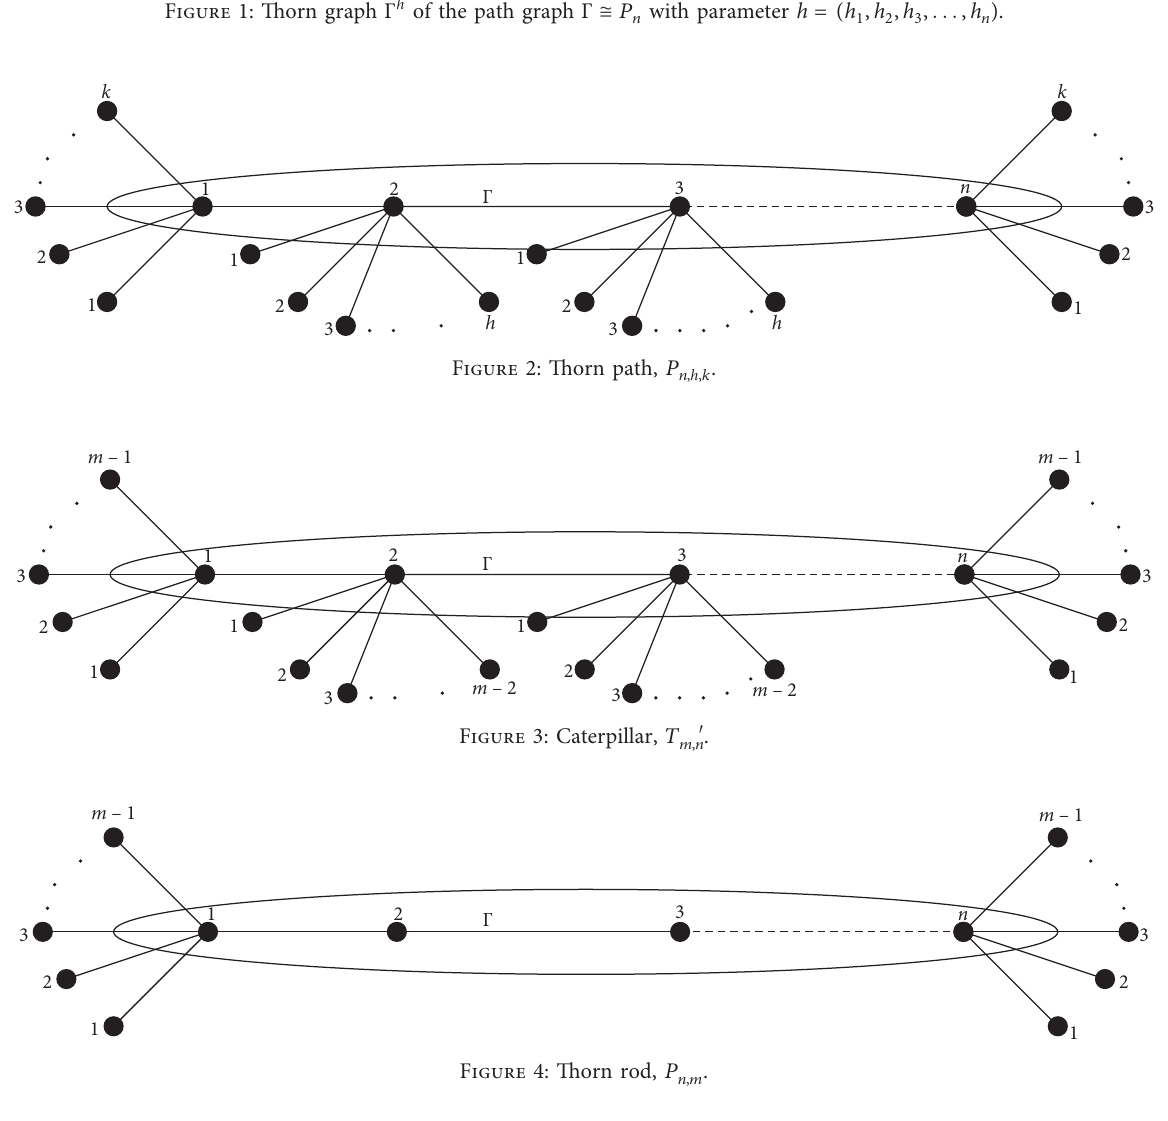
n with parameter